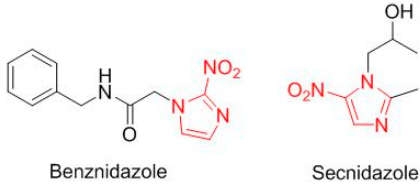
Figure 10. Structure of oxacin (in red) based drugs.